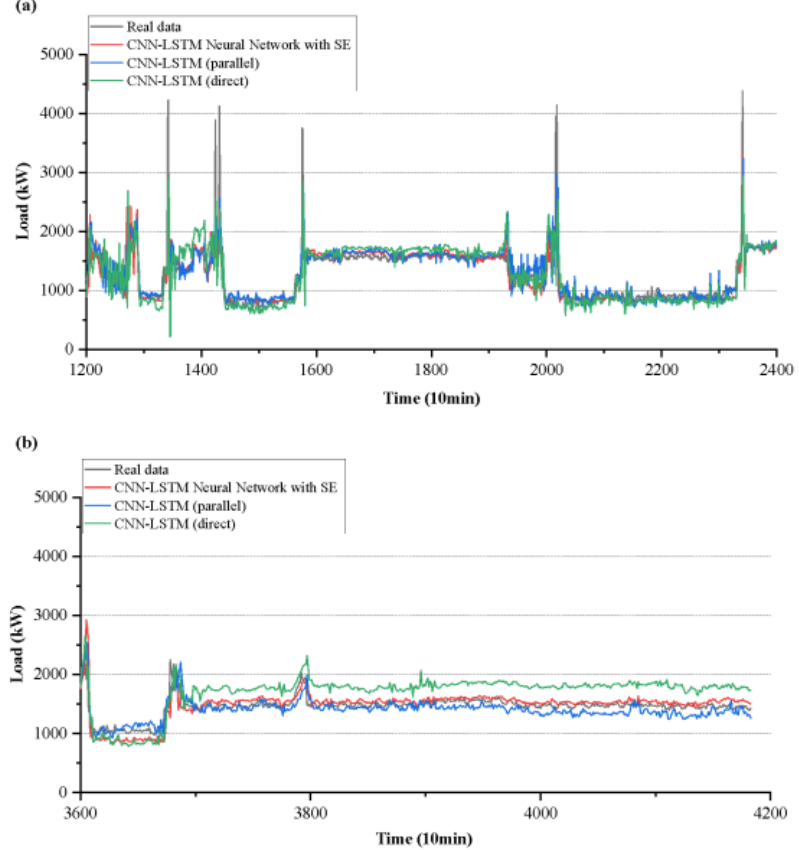
Figure 9. Detailed comparison of models using forecasting with real data: ( a ) Forecasting after heavy loading; ( b ) Power load forecasting occurring from propulsion.